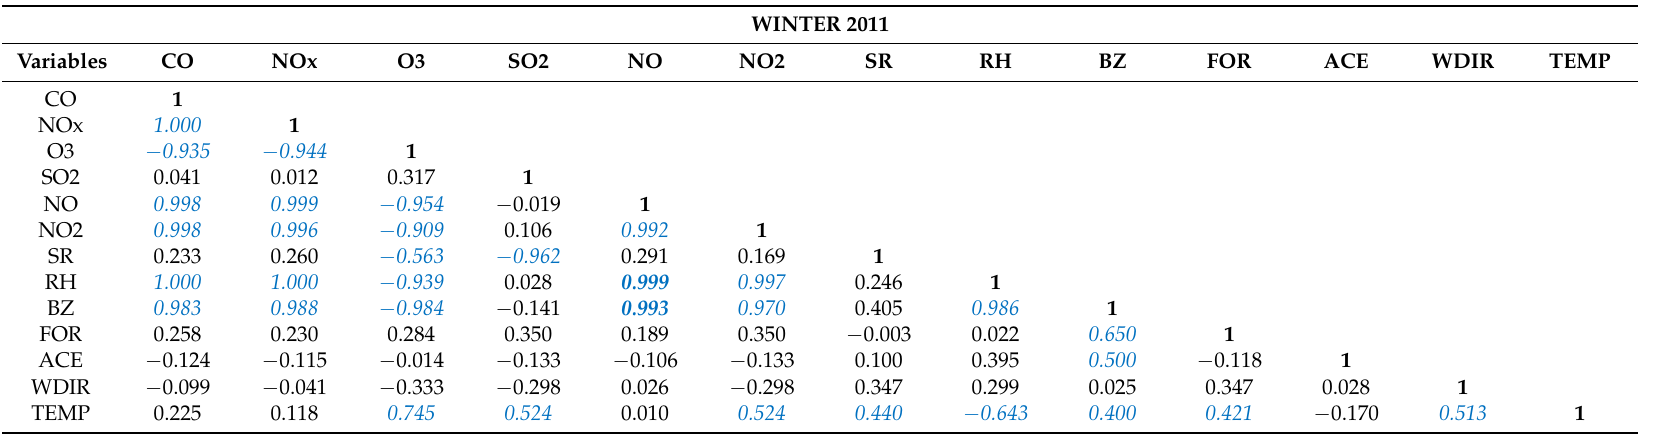
Table 7. Pearson correlation coefficients for benzene, formaldehyde, acetaldehyde, meteorological parameters, and criteria air pollutants during winter.